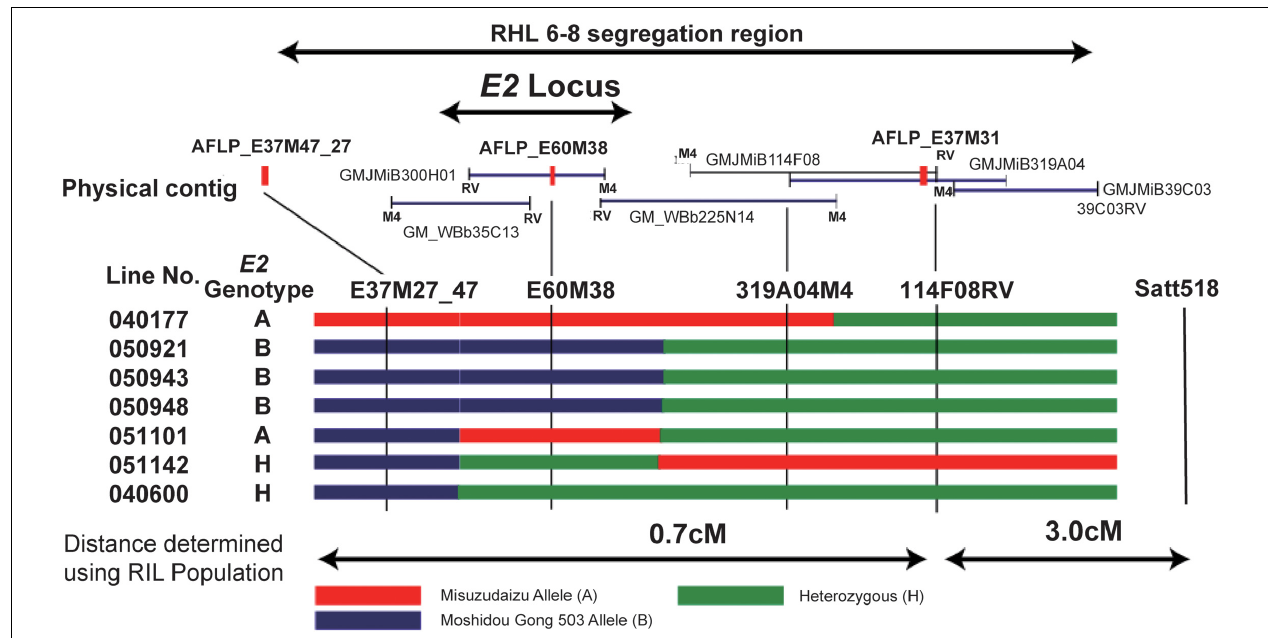
FIGURE 5 | Fine mapping of the E2 gene using residual heterozygous line (RHL) strategy. The segregation region of the line of RHL 6–8 are shown on the top. The physical contig are shown in the middle panel, in which the BAC or TAC clones and the developed markers are placed in the relative physical position. The M4 end or RV end is also indicated. Mapping using recombinants are shown in the bottom panel. Left: Recombinant line detected. Recombination is shown by black bars representing homozygous Misuzudaizu allele, white bars representing homozygous Moshidou Gong 503, and dotted bars representing the heterozygote. Genotypes of E2 are judged based on the phenotypic segregation in the next generation. The delimited E2 region is shown. Right: phenotypic segregation patterns in the following year in the progenies (Adapted from Watanabe et al., 2011).